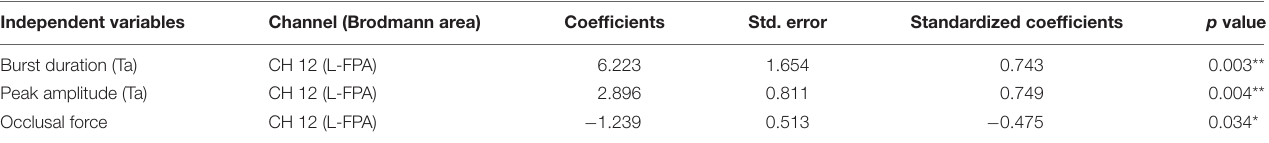
TABLE 7 | Multiple linear regression for association of prefrontal oxygenated hemoglobin concentration [(oxy-Hb)] with burst duration [anterior temporal (Ta)], peak amplitude (Ta), and occlusal force. Independent